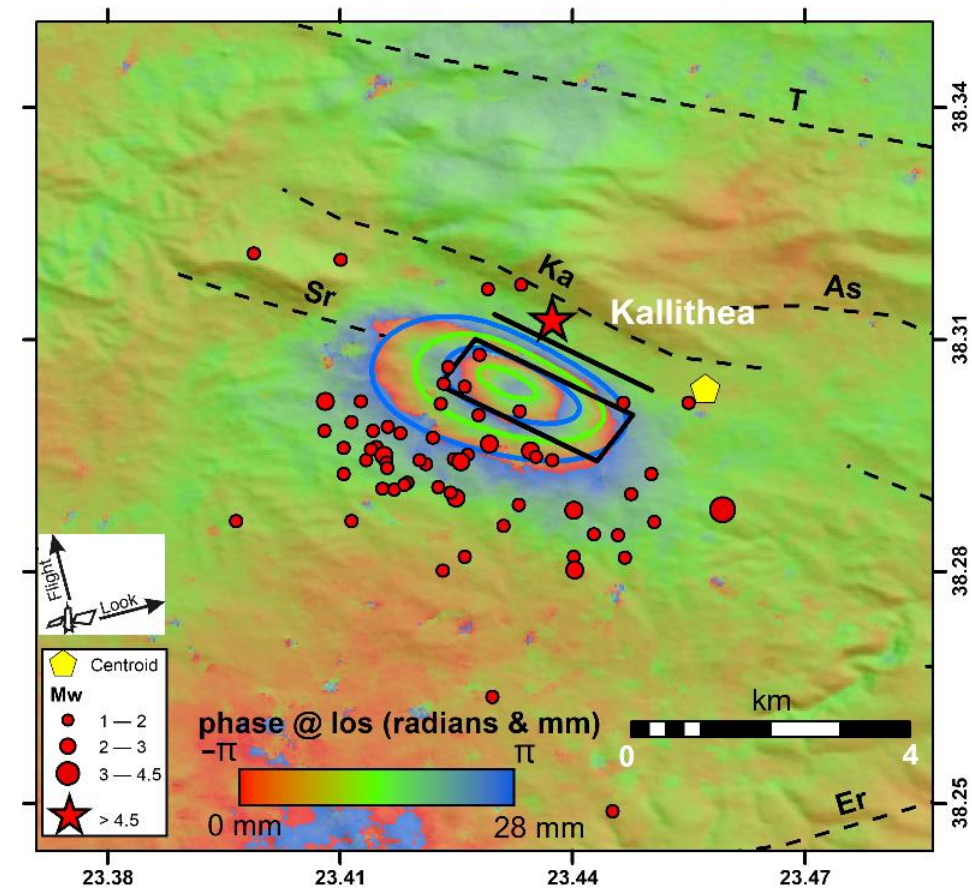
Figure 6. The ascending interferogram of track 102, spanning the dates 21 November 2020 to 3 December 2020 and the model in contour lines every half fringe (14 mm) with the same color coding. The seismological centroid is depicted with the yellow polygon. The mainshock (star), aftershocks (red circles), the faults (black dashed lines), along with the projection of the ruptured fault on the surface and its dip-up one (black rectangle and solid line) are shown. Fault names as in Figure 5.